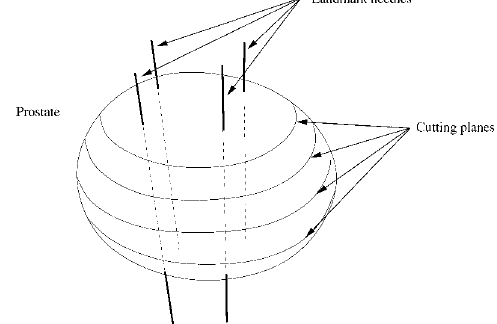
Fig. 2. The rigid needles are inserted prior to fixation, but are not bound to each other. After the needles have been removed, the prostate is cut into slices, and each slice will contain four round traces from the